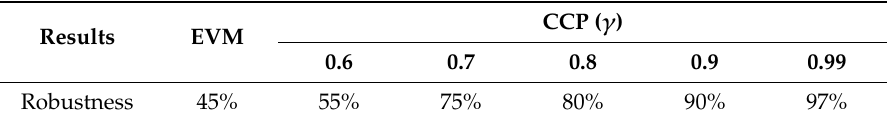
Table 8. the Robustness of EVM and